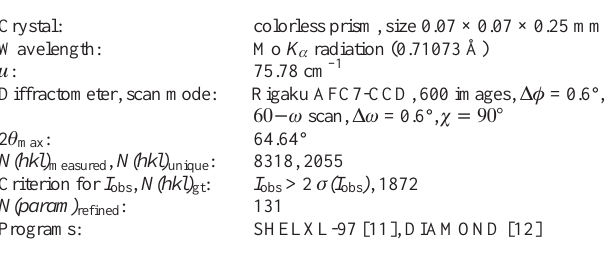
Table 1. Data collection and handling.